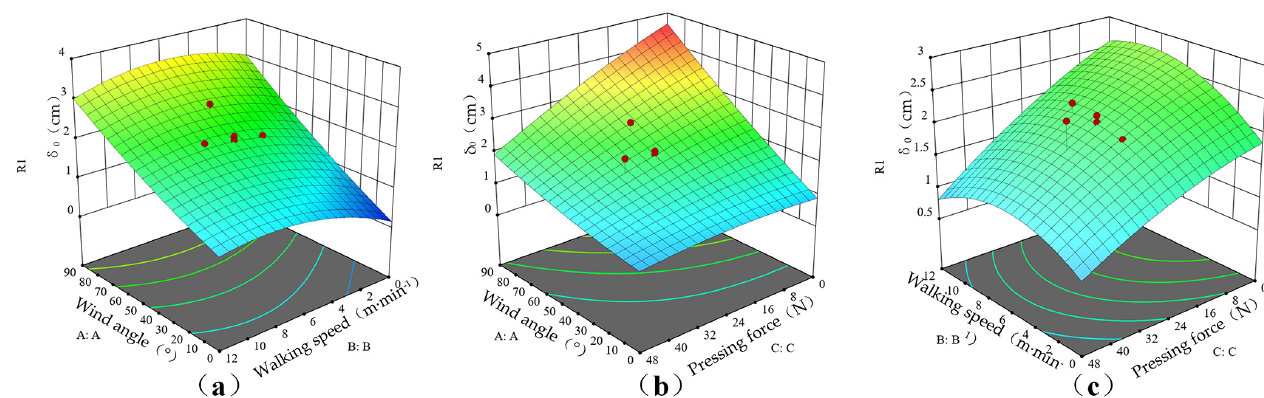
Figure 17. Effect of interaction factors on the swing displacement δ 0